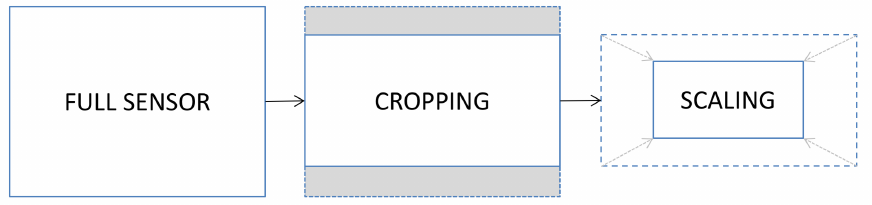
Figure 1. Workflow of the geometric transformation applied in a video